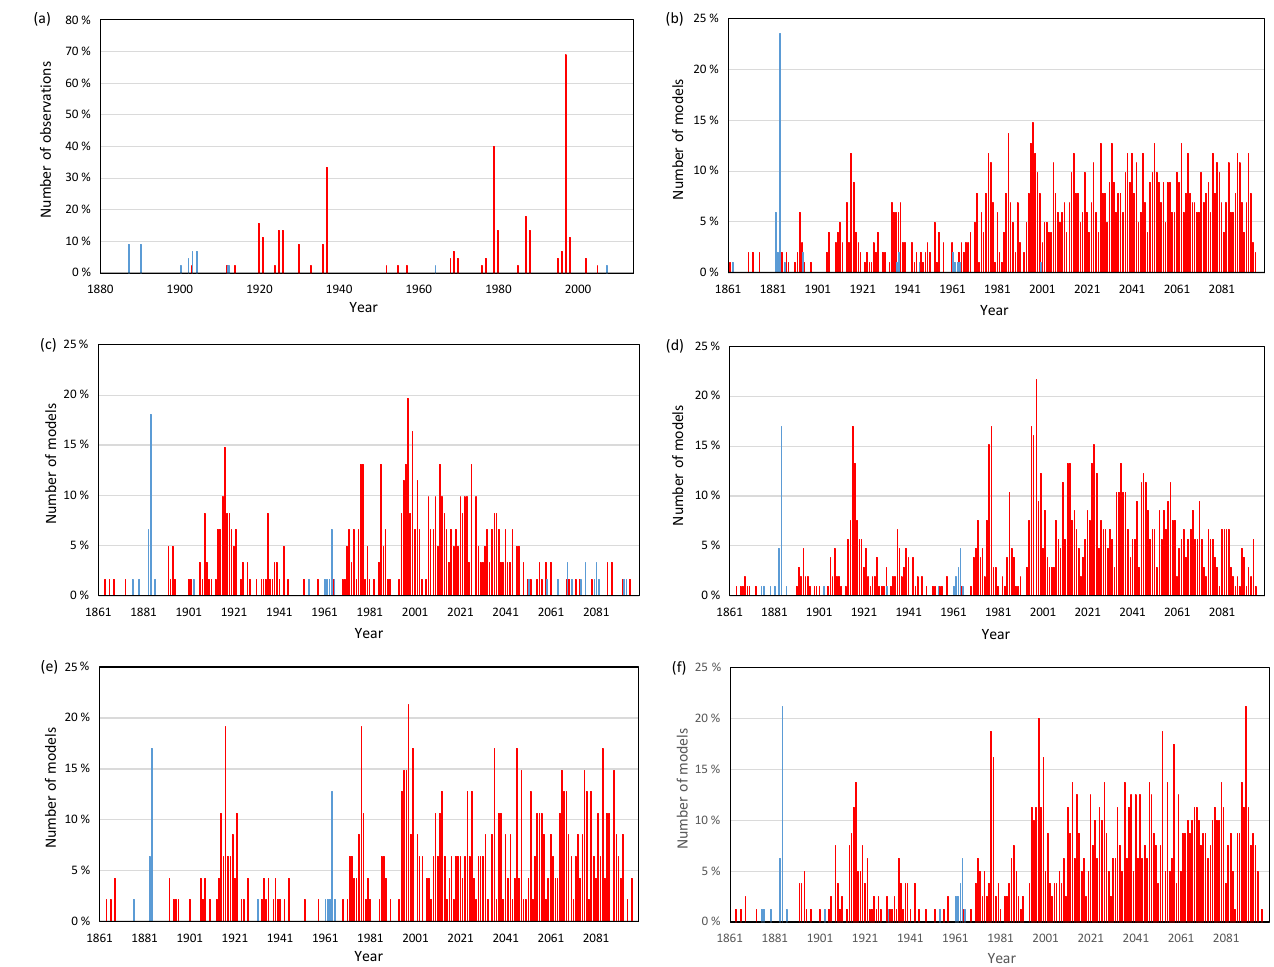
Figure 7. Step changes in observed and simulated surface temperatures. Frequency in percent of statistically significant step changes from (a) global, hemispheric and zonal averages (45, 1880–2014); (b) global mean warming from 102 model simulations from the CMIP3 archive for SRES A1b and A2 emission scenarios; (c–f) global mean warming 1961–2100 from the CMIP5 archive for the (c) RCP2.6 pathway (61), (d) RCP4.5 pathway (107), (e) RCP6.0 pathway (47) and (f) RCP8.5 pathway